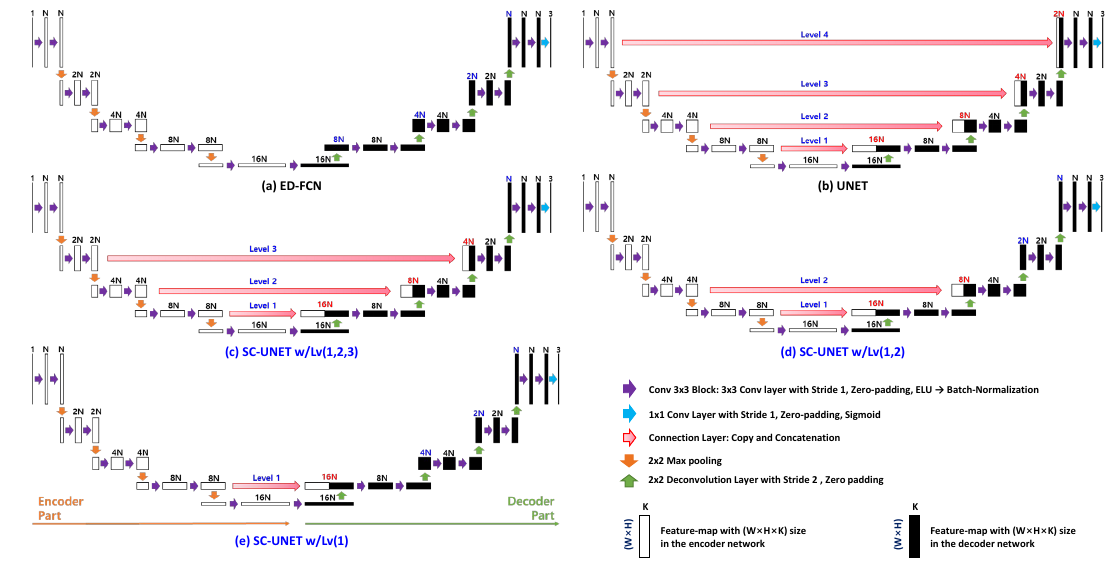
Figure 3. Conventional and proposed selected connection UNET (SC-UNET) network architectures for color image generation from LiDAR reflection intensity. ( a , b ) Conventional network architectures; ( c – e ) proposed SC-UNET network architectures; the feature maps of the encoder part are combined in the form of concatenation into the feature maps of the decoder part in the networks shown in ( b – e ). All architectures consist of fully convolutional networks and have the following common